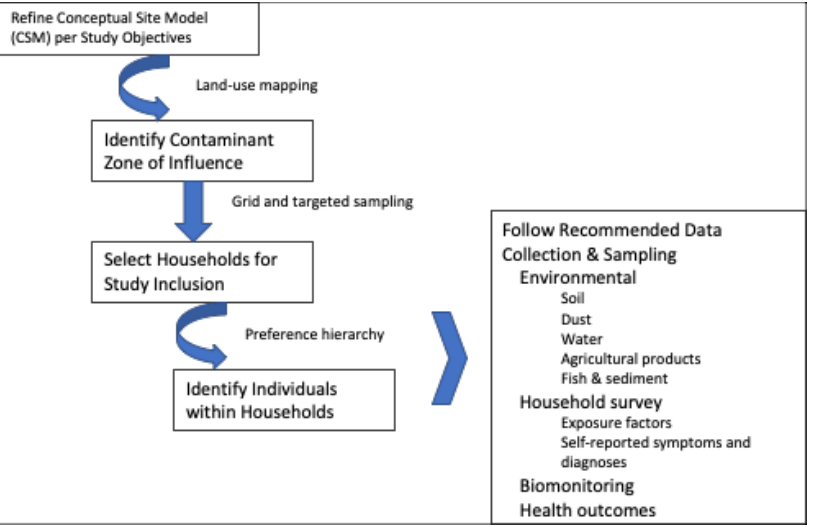
Figure 1. Overview of framework to support health impact studies in